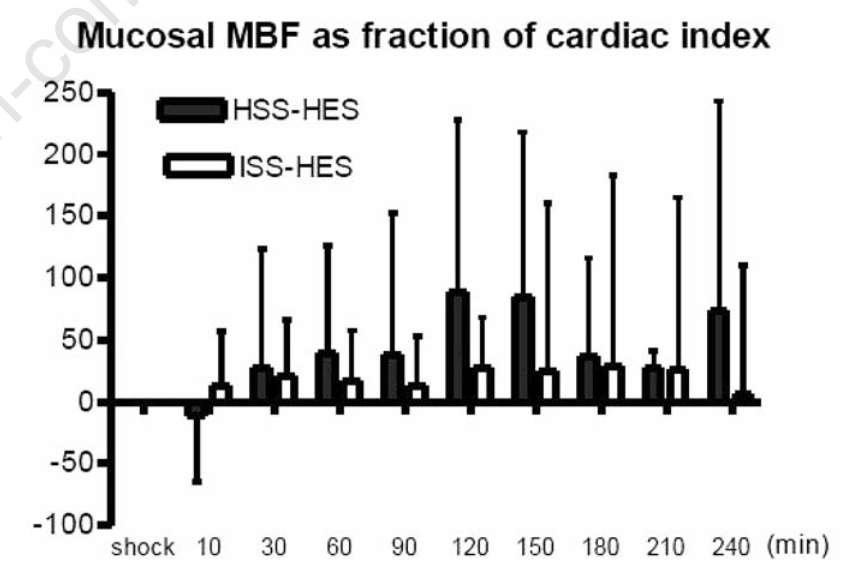
Figure 5. Changes in mucosal microcirculatory blood flows (MBF) compared with changes in cardiac index during fluid administration after the onset of septic shock. Pigs were resuscitated with hypertonic saline 7.2%/hydroxyethyl starch (HSS-HES) or isoton- ic saline 0.9%/hydroxyethyl starch (ISS-HES). The ratio between mucosal MBF and car- diac index at shock was set at 0. Data are presented as